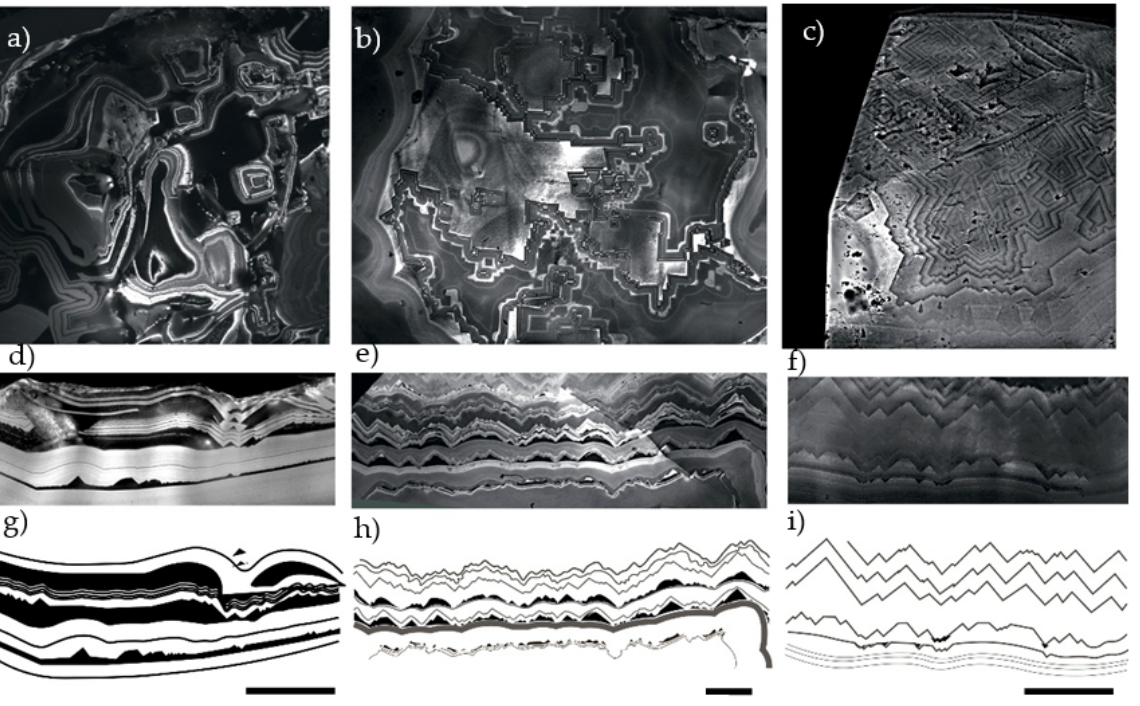
Figure 4. Different options of the initial transition stage from normal to regeneration growth in rounded diamond crystals. First row ( a – c ): CL images of the crystal surfaces with tetragonal depressions in <100> direction; regeneration {111} zoning is clearly visualized on the dissolved crystal surface. Second row ( d – f ): cross-sections of the same crystals on <100> plates, orthogonal to the surfaces in the first row. Third row ( g – i ): a schematic view of the revealed zoning in the cross ‐ section of the plate. The scale bar is 0.2 mm.